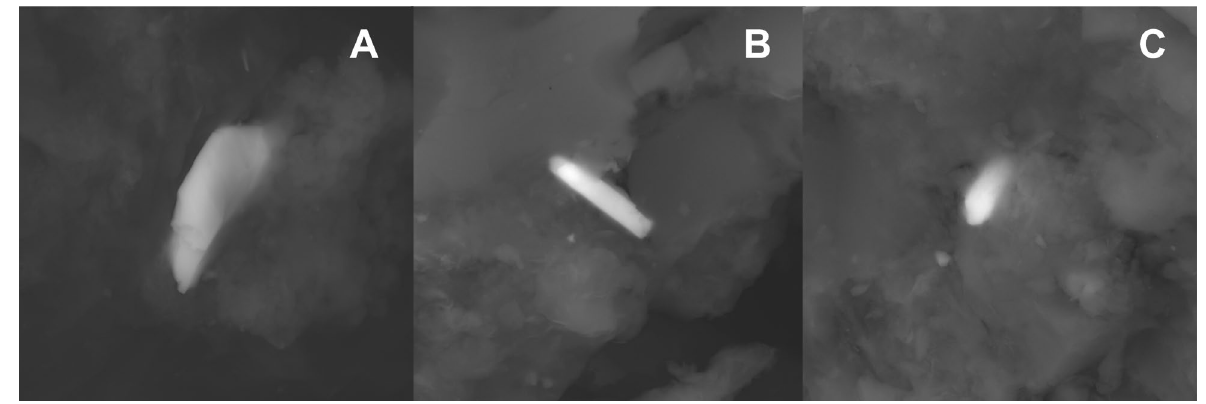
Fig. 6 Rare-metal microphases from metalliferous coals of the Rakovka brown coal deposit: a REE phosphate (monazite); b Zircon; c Yttrium phosphate (xenotime)